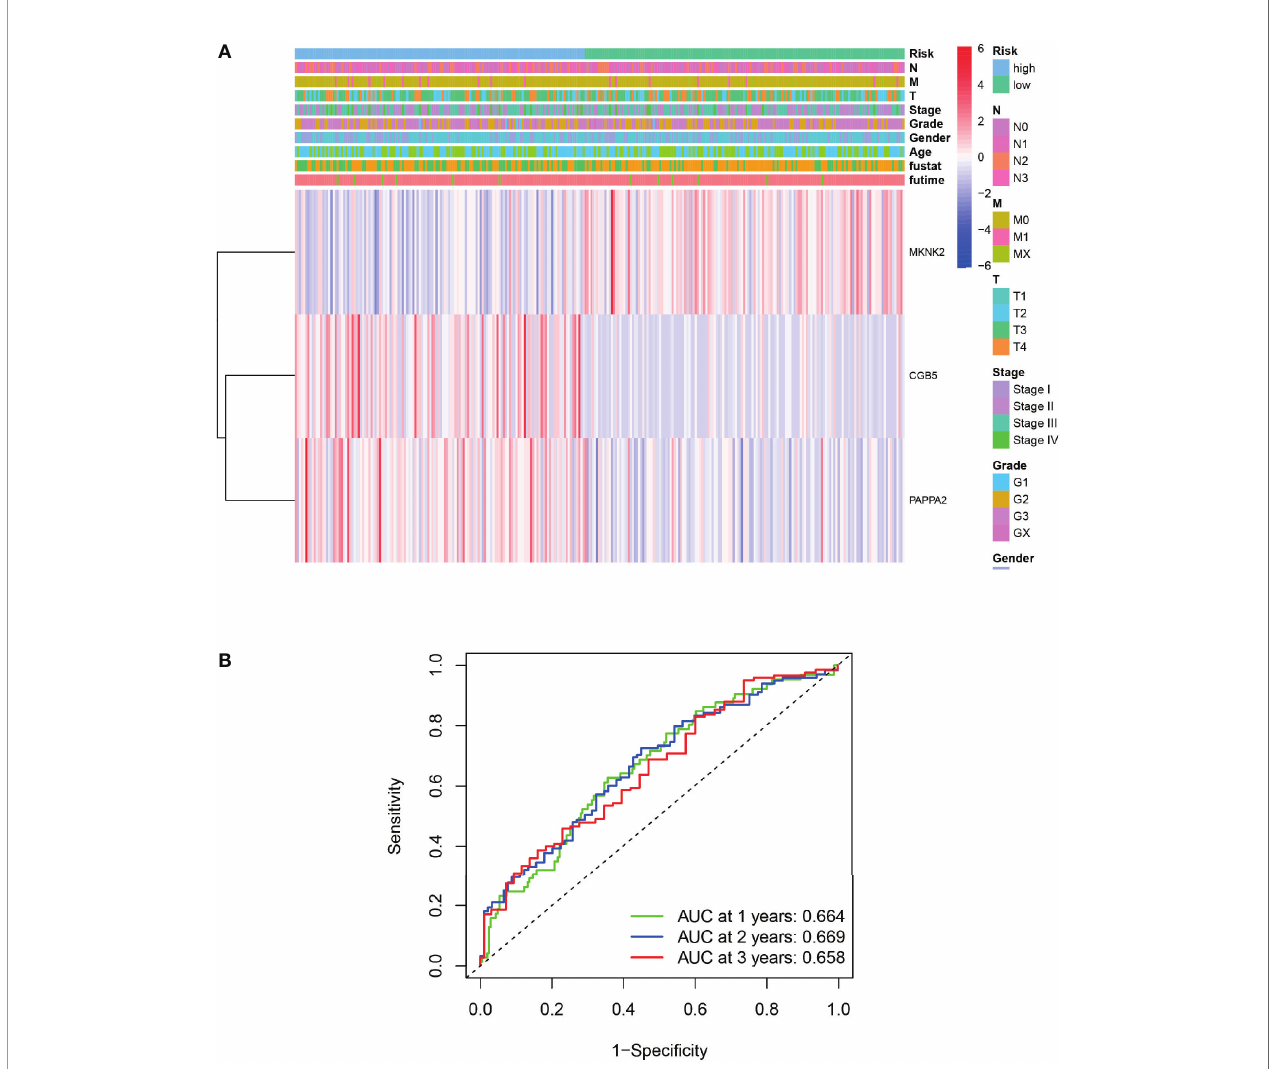
FIGURE 8 | ROC Diagnostic Curve and Clinical Correlation Analysis. (A) Represents the relationship between the three genes used to construct the model and the clinical information. (B) Represents the AUC values for 1, 2 and 3 years were 0.664, 0.669 and 0.658,